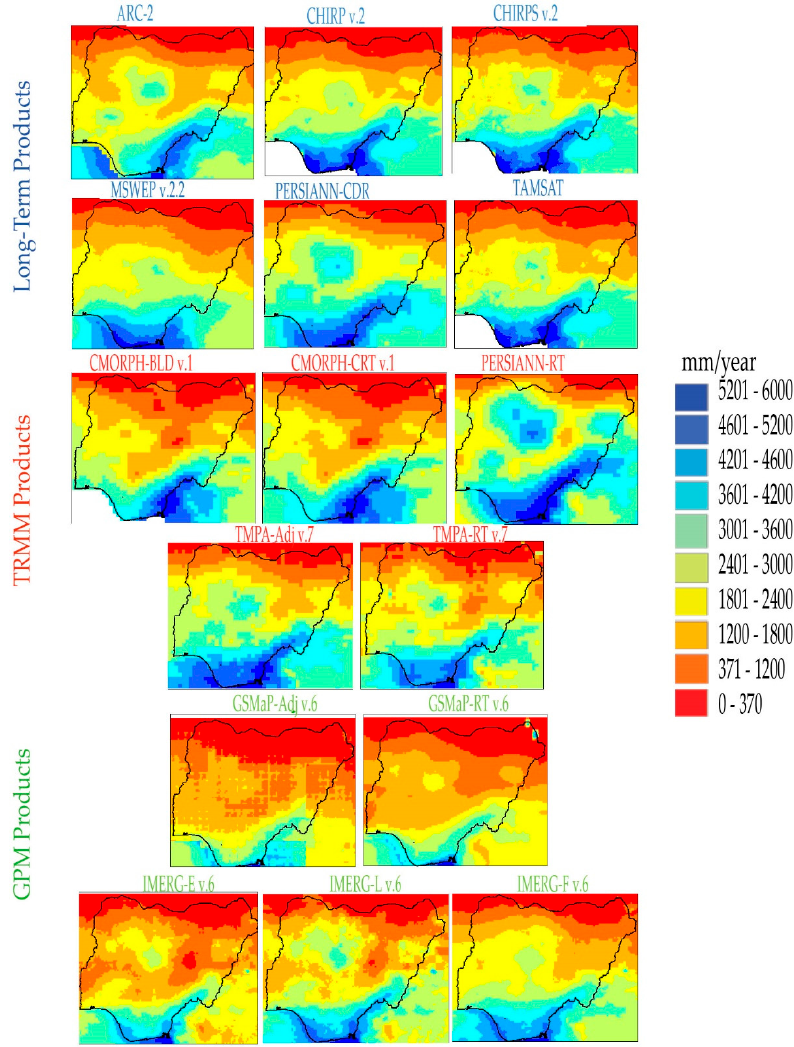
Figure 2. Mean yearly precipitation retrieved from all the satellite-based precipitation products (SPPs) at their original grid size from 2000–2012.